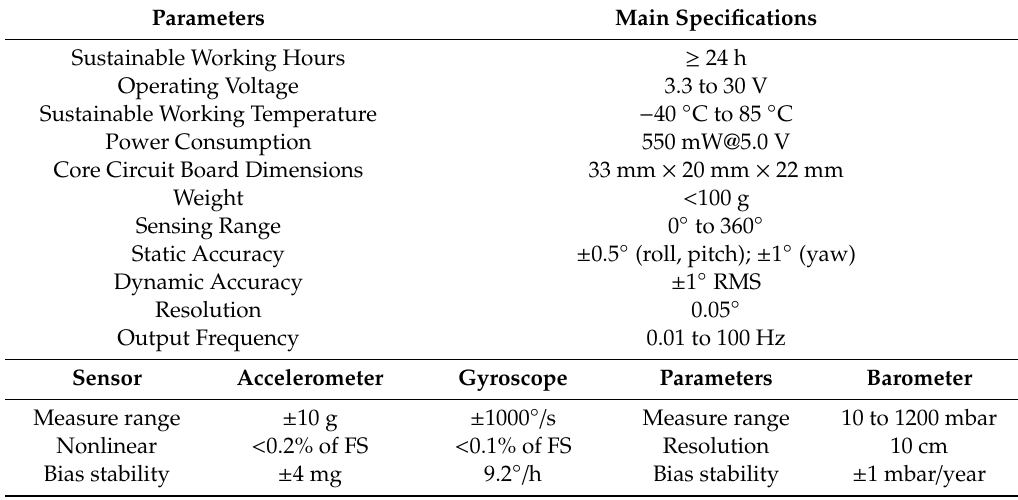
Table 7. Main specifications of devices.